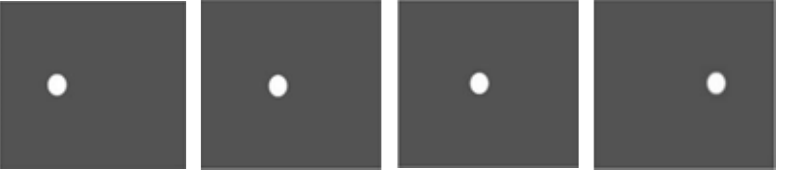
Figure 12. Synthetic video. A ball moves from left to right along with a tiny vibration in the vertical direction [21].